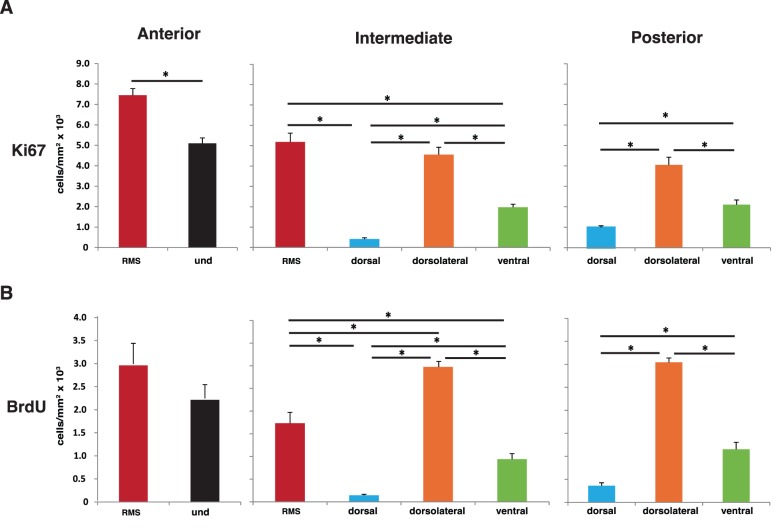
Combinatorial analysis of cell proliferation in the subependymal zone anterior-posterior and dorsal-ventral axes.The proliferation rate in the different dorsal-ventral regions was assessed at the anterior, intermediate and posterior levels either with Ki67 (A) or BrdU (B). Proliferation pattern analysis in dorsal-ventral SEZ regions along the defined anterior to posterior axis revealed that proliferation in the RMS significantly decreased from the anterior to the intermediate division. Cell proliferation in the dorsal, dorsolateral and ventral regions was not significantly affected in the intermediate to posterior divisions transition. Proliferation is expressed as number of Ki67 and BrdU positive cells per area (mm2). The threshold value for statistical significance was set at 0.05 (* p<0.05).